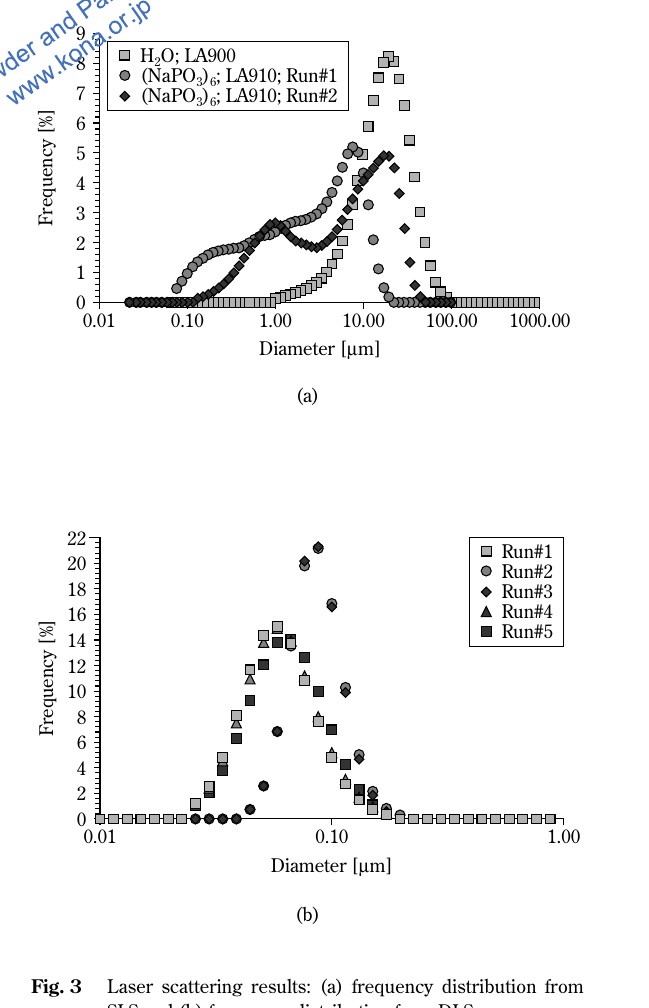
Fig. 3 Laser scattering results: (a) frequency distribution from SLS and (b) frequency distribution from DLS.